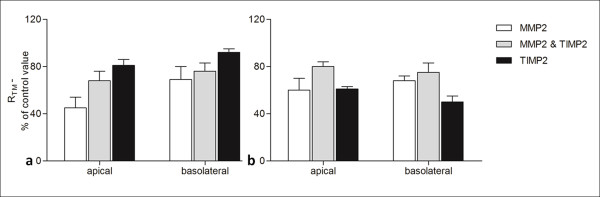
TIMP2 reverses partially the effect of MMP2 on pleural permeability. TIMP2 was added at concentration 200 ng/ml at on the apical and basolateral side of parietal(a) and visceral(b) pleura. MMP2 was added at the same time at concentration 20 ng/ml. TIMP2 seems to prevent partially the decline in RTM induced by MMP2 on the 40th minute of the experimental procedure. Data are given as mean ± SD. n = 6 for MMP2, n = 3 for combined MMP2 and TIMP2, n = 3 for TIMP2.